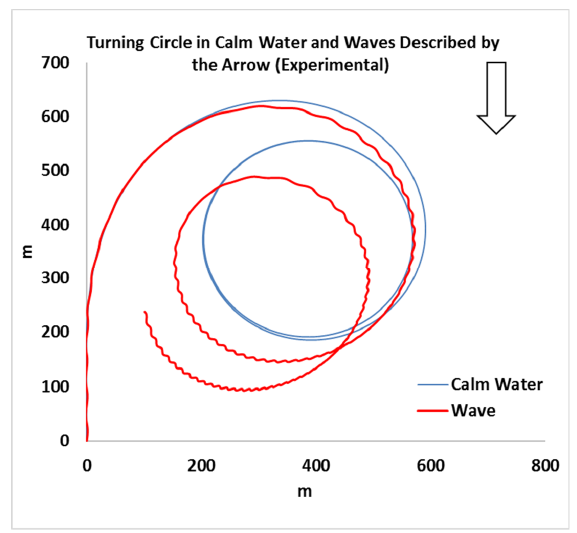
Figure 12. KCS’s experimental starboard-side 35 deg turning trajectories in calm water and regular wave with 180 deg at t = 0.